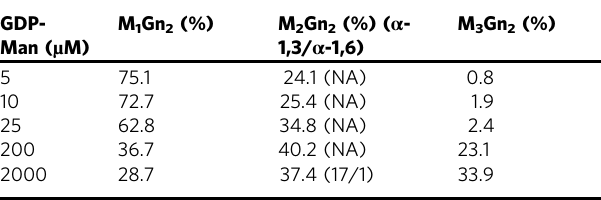
Table 4 Relative percentage of oligosaccharides in hAlg2 reactions with 25 μ M of GDP-Man